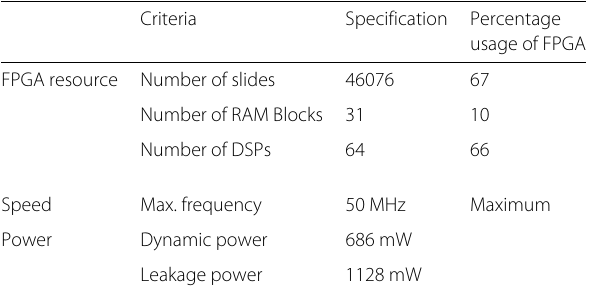
Table 4 FPGA specification on Stratix III EP3SL150F1152C2N